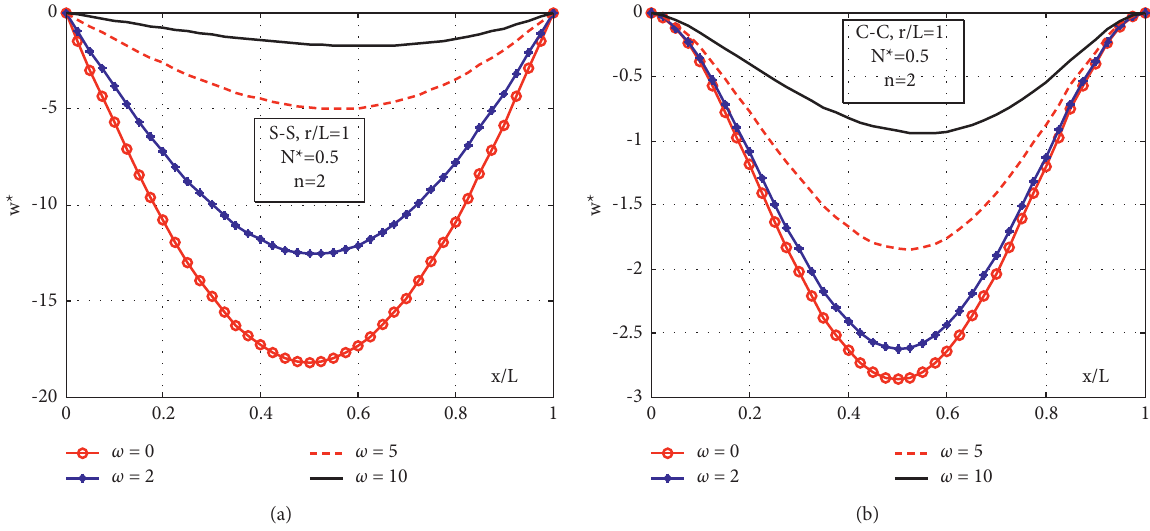
Figure 5: The FG beam’s deflection line as a function of rotating speed, K ∗